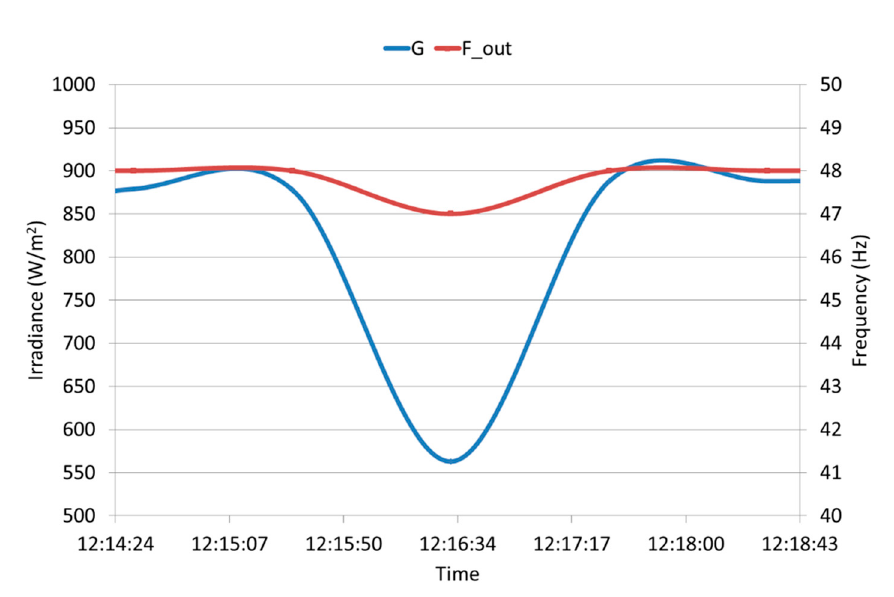
Figure 10. Passing clouds’ routine on 2nd August 2018.